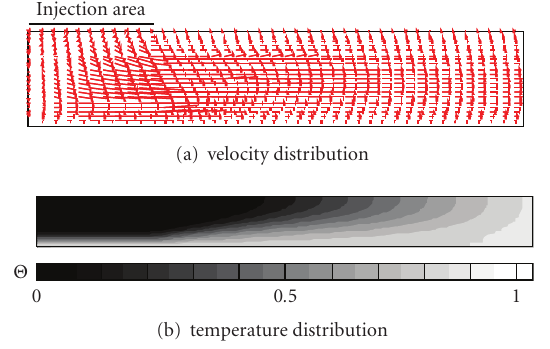
Figure 6: Velocity and temperature distributions in rotating disk at h/D i = 0 . 05, Re = 2000 and Re t = 2000.